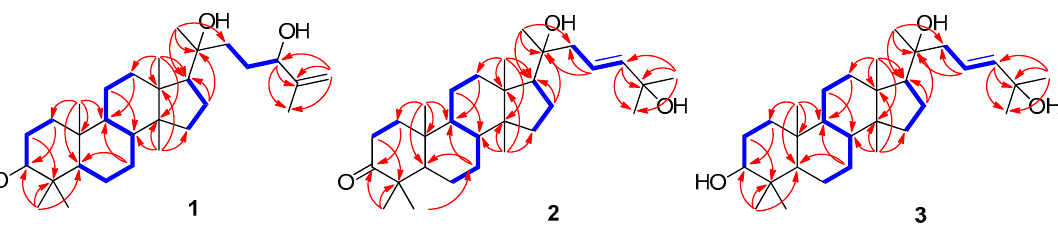
→ ) correlations for compounds 1 – 3